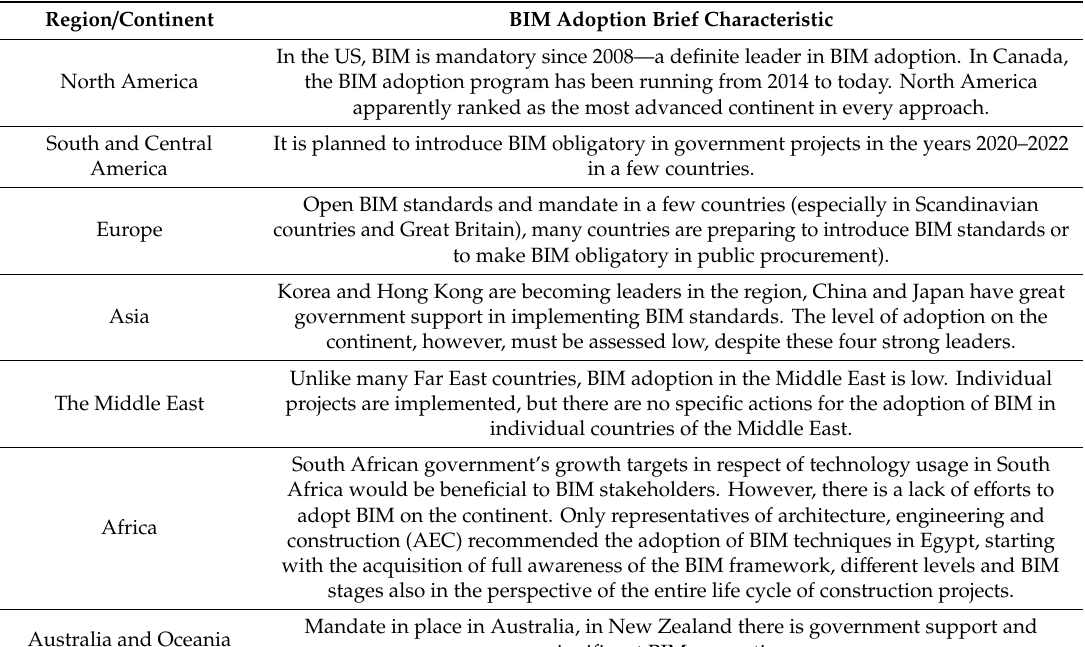
Table 2. BIM adoption by regions (own